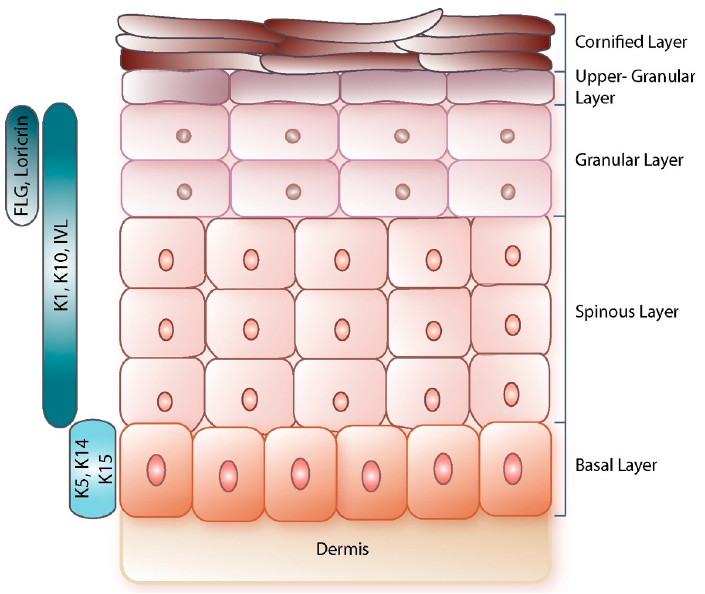
Figure 1. Schematic of the human epidermis. The human epidermis is a pluristratified tissue made up of basal, spinous, granular, upper-granular and cornified layers, in ascending order. The keratinocytes in the basal layer express keratins K5 and K14, as well as K15, which are then substituted by markers of epidermal differentiation such as K1, K10, IVL in the spinous layer. With progression of differentiation, other markers such as FLG and loricrin are expressed in the granular layer. The keratinocytes at the level of the cornified layer are called corneocytes as they are devoid of organelles and nuclei and are finally sloughed